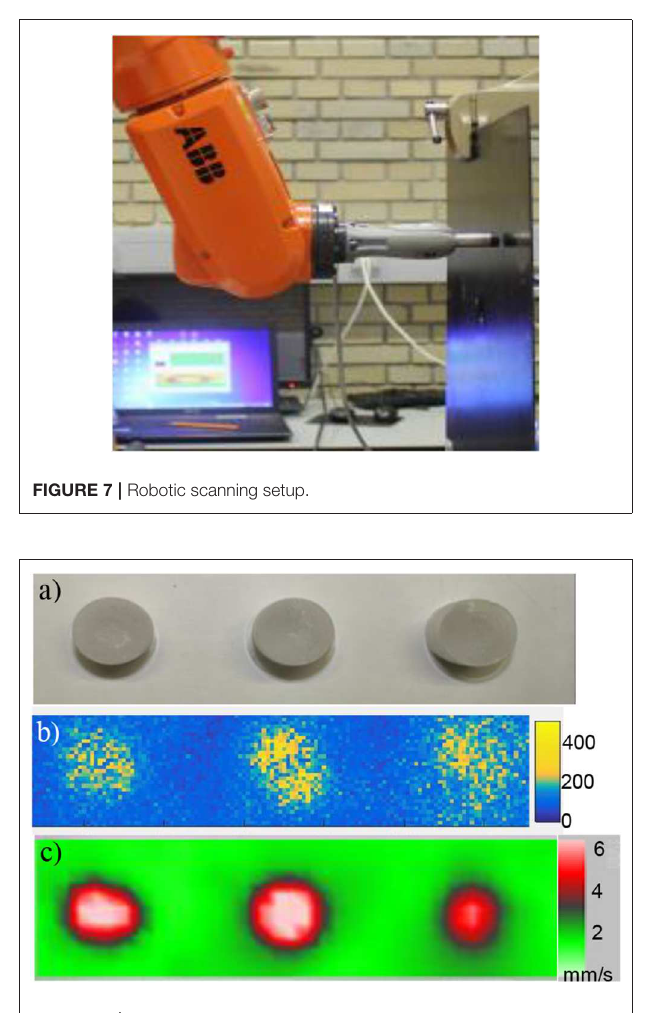
FIGURE 8 | (a) photo of three FBH in plexiglass; (b) multiple RACE images in a single scan noisy mode; (c) laser vibrometer image of FBH excited on their LDR